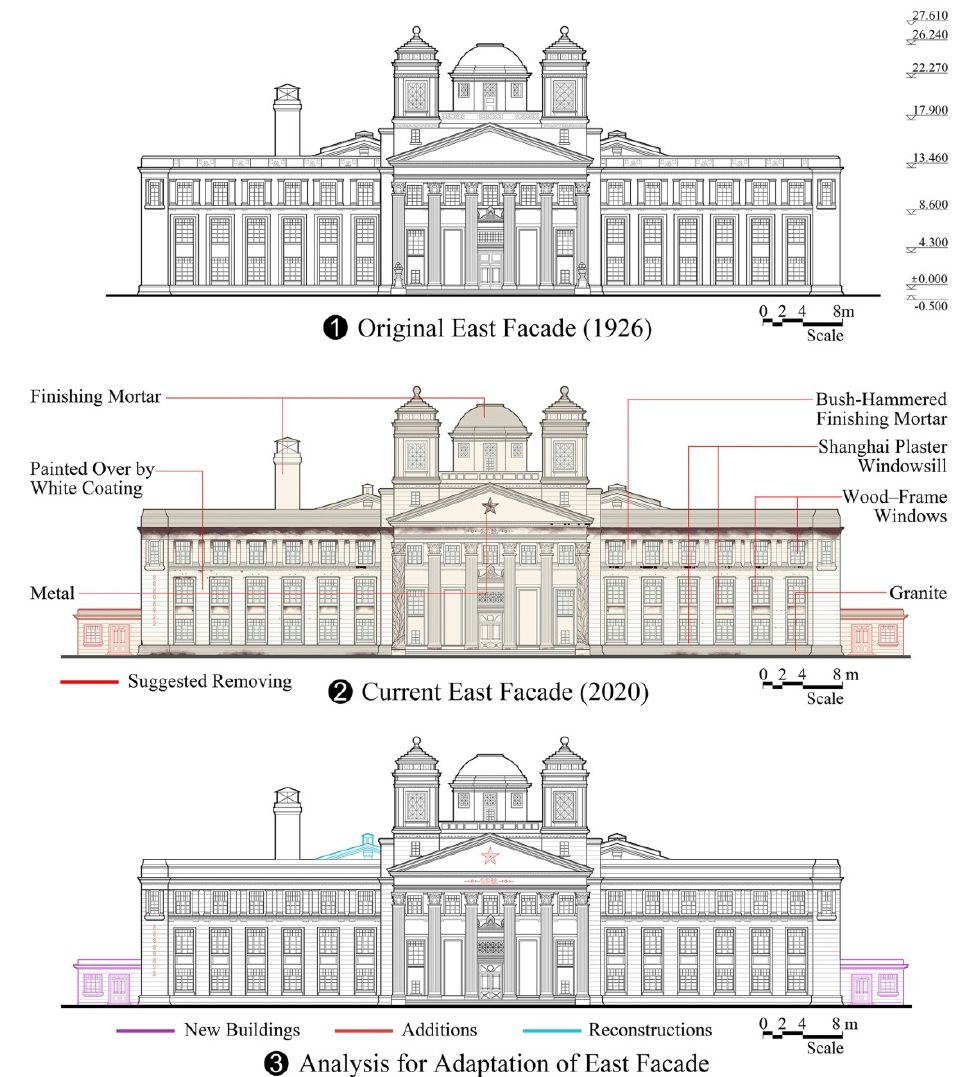
Figure 11. East Facade of Qingdao Exchange Building.